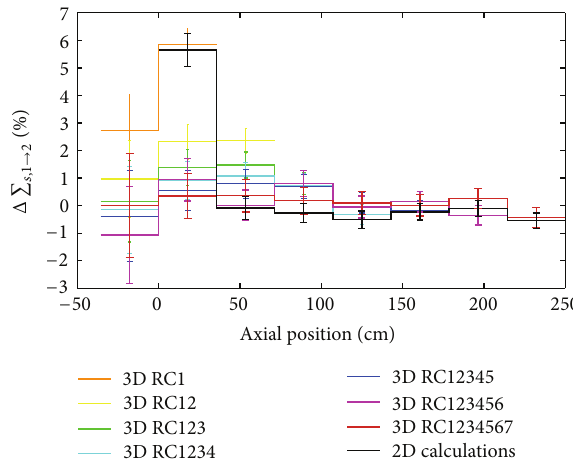
Figure 20: Relative differences between down scattering cross sections.